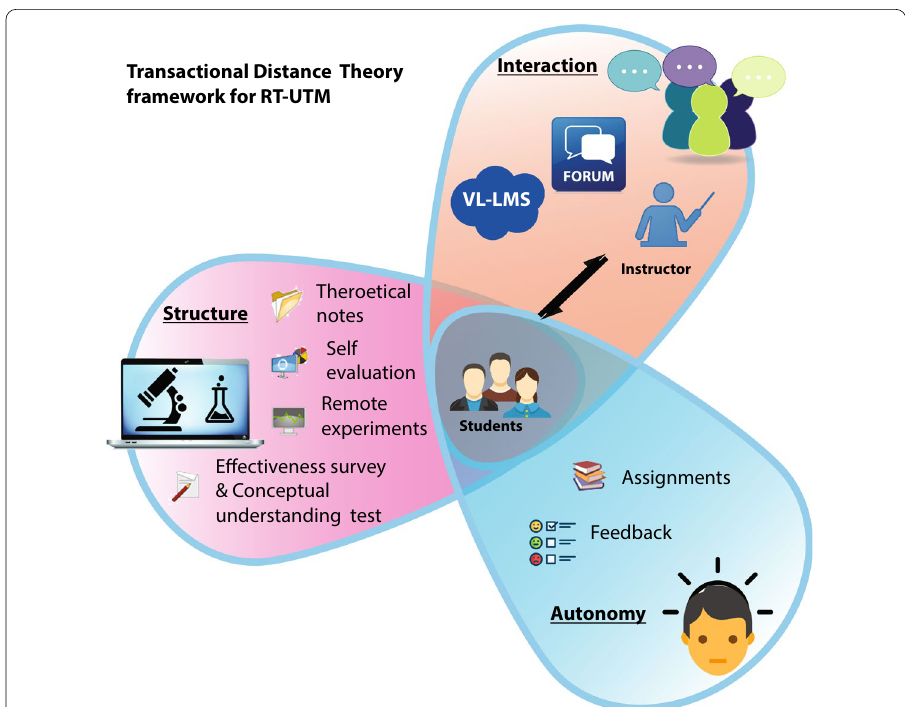
Fig. 1 Transactional distance theory framework for